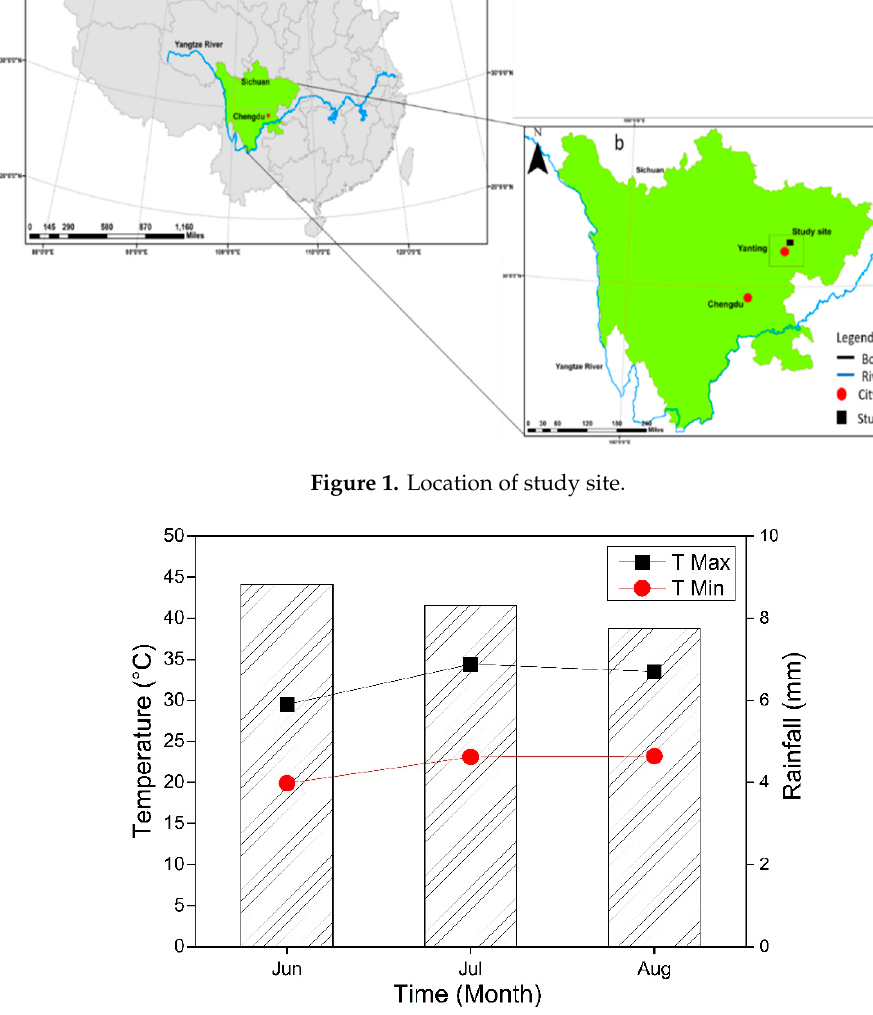
Figure 2. Climatic conditions during the experimental period.